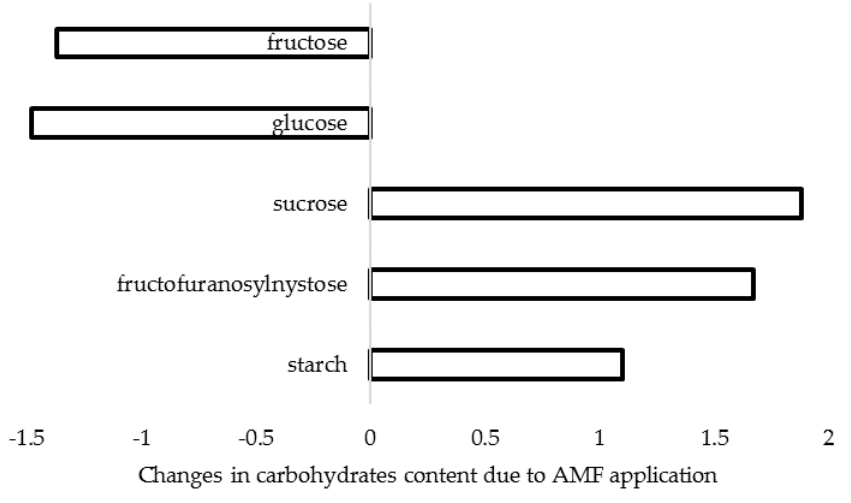
Figure 2. Changes in carbohydrate content in A. cepa bulbs as a result of G. intraradices and G. mosseae inoculation (data re-elaborated from Lone et al., 2015 [71]).